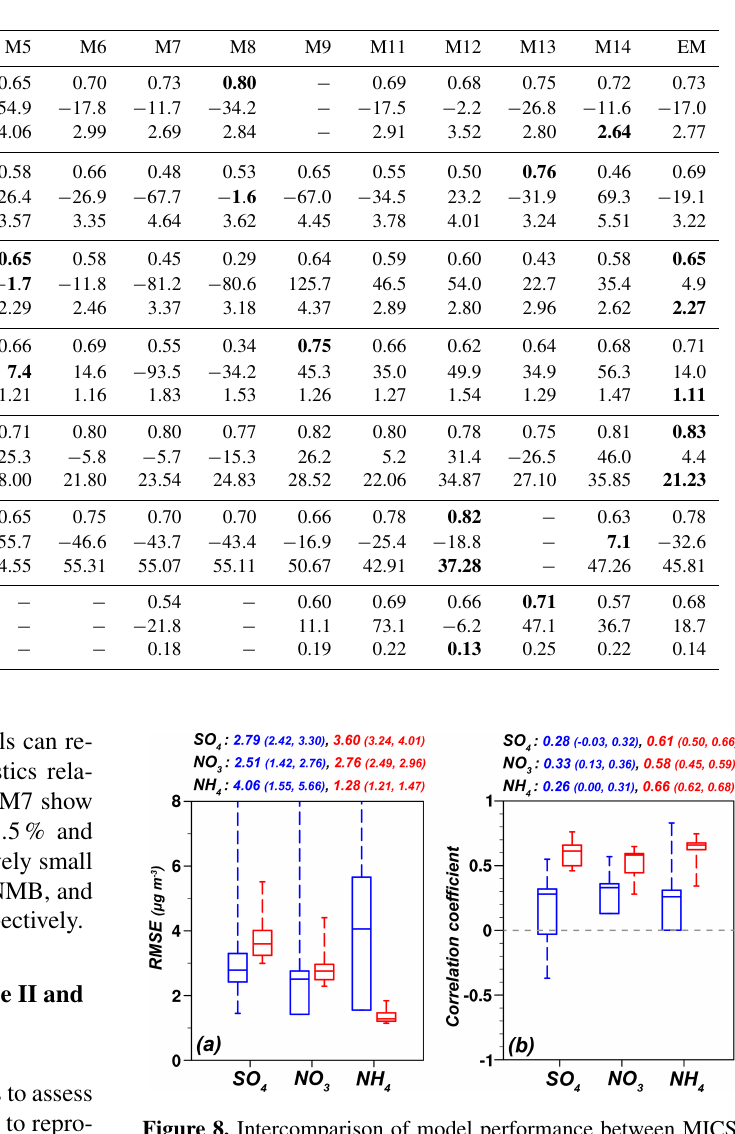
, NO − , and NH + . 4 3 4